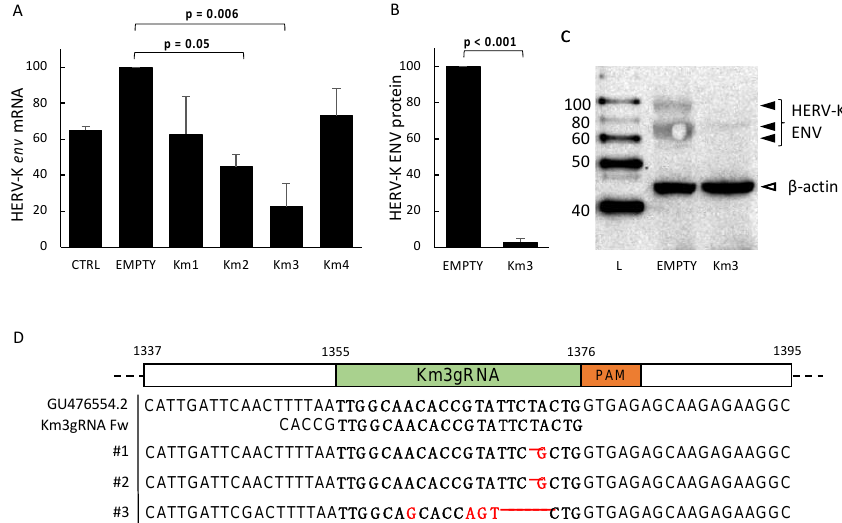
Figure 2. Expression of the HERV-K env gene in LNCaP cells exposed to the empty SaCas9 plasmid or to the pX601-Km(X) gRNA plasmids, and sequences of the targeted HERV-K env gene region in cells exposed to HERV-K env Km3 gRNA. ( A ) Mean HERV-K env mRNA levels in LNCaP cells exposed to the empty plasmid or to the pX601-Km(1-4) gRNA plasmids, as detected by real time (RT)-qPCR in five different experiments, run in duplicate, and reported as percent of the value of mock-transfected cells in each experiment. For controls of specificity, see Methods. ( B ) Mean levels of the HERV-K Env protein, as detected by Western blot in four different experiments performed with Km3 gRNA, run in duplicate; see Methods for details. Data are reported as mean intensity of the Env-specific stain of the band of interest, normalized with respect to that of the β -actin reference protein. ( C ) Row appearance of HERV-K Env bands in Western blot, as detected in a representative experiment with Km3 gRNA; ( D ) Sanger sequencing analysis on the genome region affected by the cut. CTRL: control; Empty: empty plasmid; Km1-4: Km(1-4) gRNAs. L: Ladder (MagicMark XP Western Protein Standard, Thermo Fisher Scientific); GU476574.2.: Reference sequence accession number; Km3 gRNA Fw: gRNA sequence including overhangs from the BsaI restriction enzyme; #1, #2, #3: Sequenced DNA coming from different bacterial colonies.